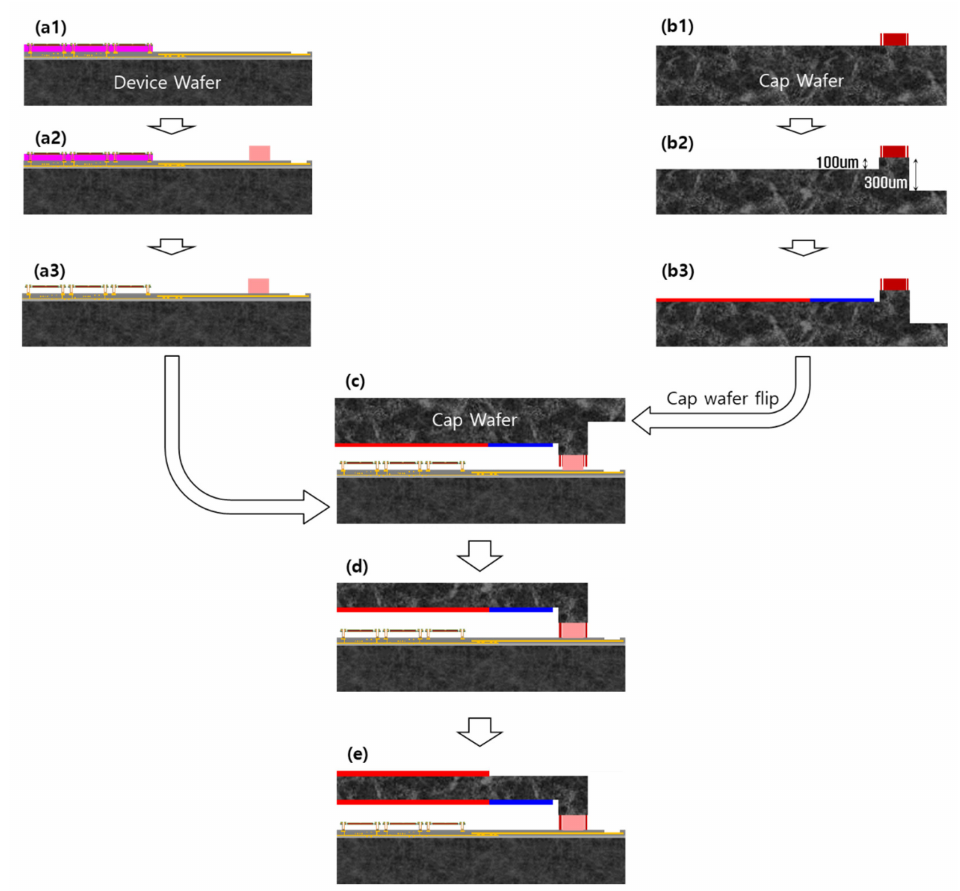
Figure 1. Fabrication process of the device and cap wafer. ( a1 ) Device wafer, ( a2 ) bonding metal deposition, and ( a3 ) membrane release of device wafer. ( b1 ) Cap wafer bonding metal deposition, ( b2 ) two-step cavity etch by DRIE, and ( b3 ) getter, AR deposition by shadow mask. ( c ) Align